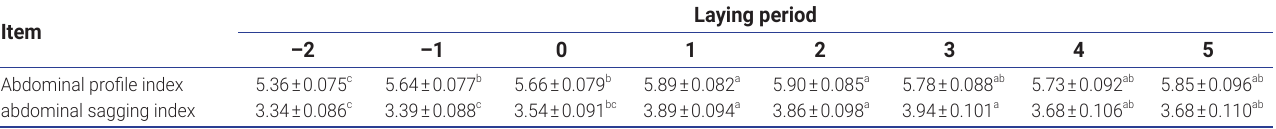
Table 2. Effect of laying period on abdomina profile score and abdominal sagging index of breeding